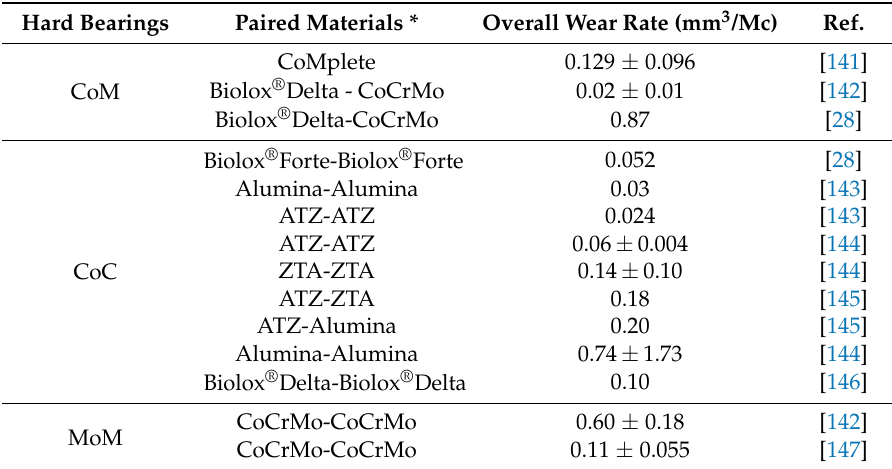
Table 2. Hard bearings wear rates found in vitro through